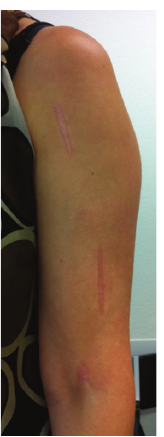
Figure 3: Photograph of the left arm of the patient shows the three scars of the minimally invasive operation technique. Distally a stab incision was made above the antecubital